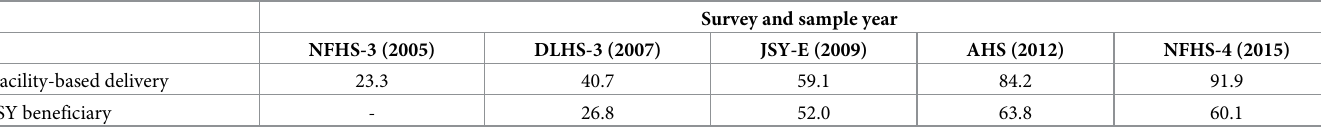
Table 4. Facility based delivery (%) and JSY beneficiaries (%) in rural Sri Ganganagar, Rajasthan according to different